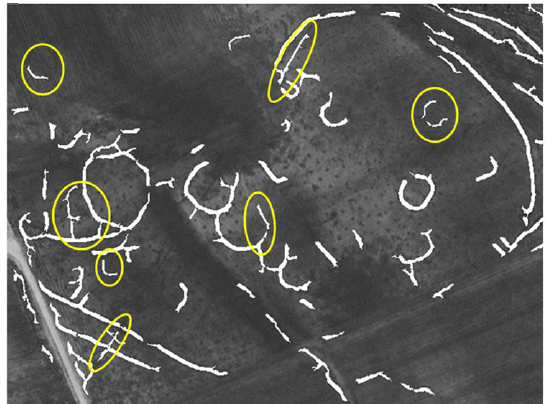
Figure 12. The results obtained after the application of two iterations of the proposed methodology with two different spacings on the real image of Figure 10. The yellow circles highlight the lines which are detected after the second iteration with a smaller window